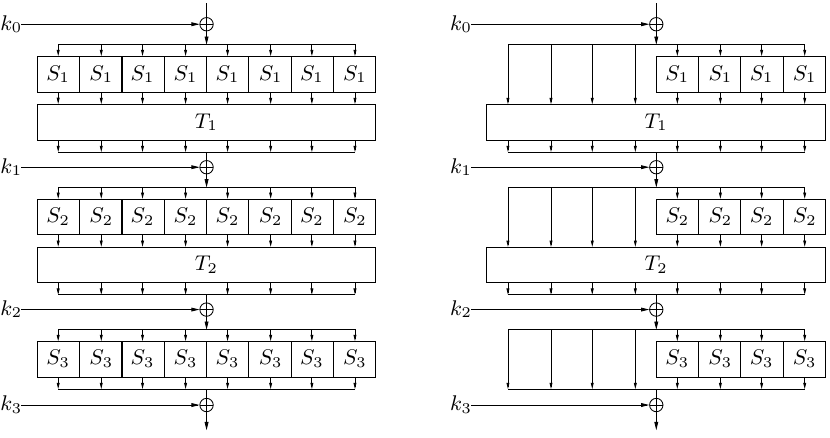
Figure 3: SP and partial SP networks, with w = 8. (Left) the 3-round linear SPN